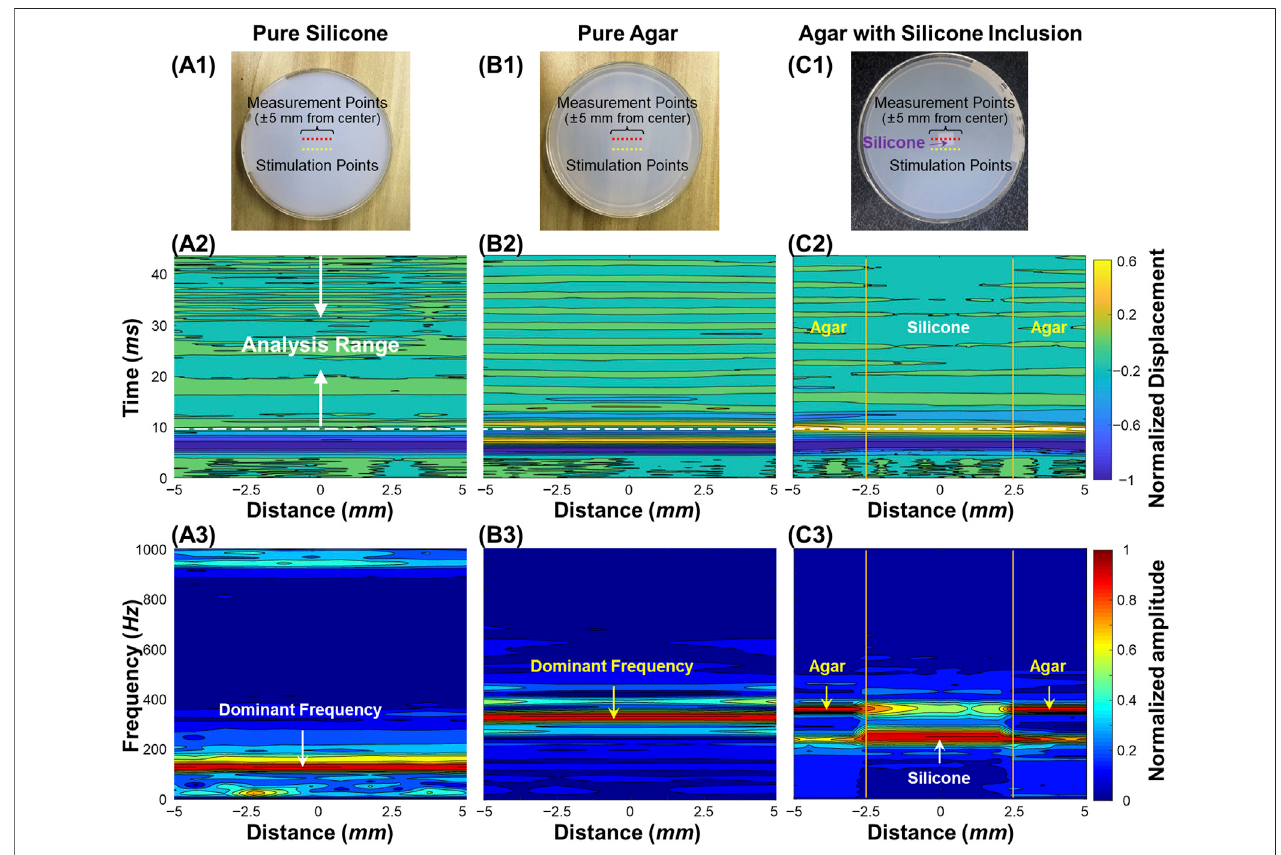
FIGURE 3 | Oscillation feature analysis for the homogeneous and heterogeneous phantom samples. (A1 – C1) : Top views of the silicone, agar, and silicone-agar mixturephantoms.Themeasurementswereperformedat21pointstocovera10 mmscanlength.Thedistancebetweeneach stimulationandmeasurementpointwas 3 mm. (A2 – C2) : Normalized surface displacement pro fi les in time domain. Fast-Fourier transformation was performed in the analysis range of 10 – 43 ms for oscillation frequency feature analysis. (A3 – C3) : Normalized frequency spectrum in response to the measurement locations for different phantoms. The dominant oscillation frequencies were 128.7 ± 1.0 Hz for the silicone phantom (A3) and 329.7 ± 16.5 Hz for the agar phantom (B3). In (C3), the silicone block can be distinguished in the silicone-agar mixture phantom due to distinct frequency features, which were 247.9 ± 0.7 Hz for the silicone block and 357.6 ± 0.8 Hz for the agar